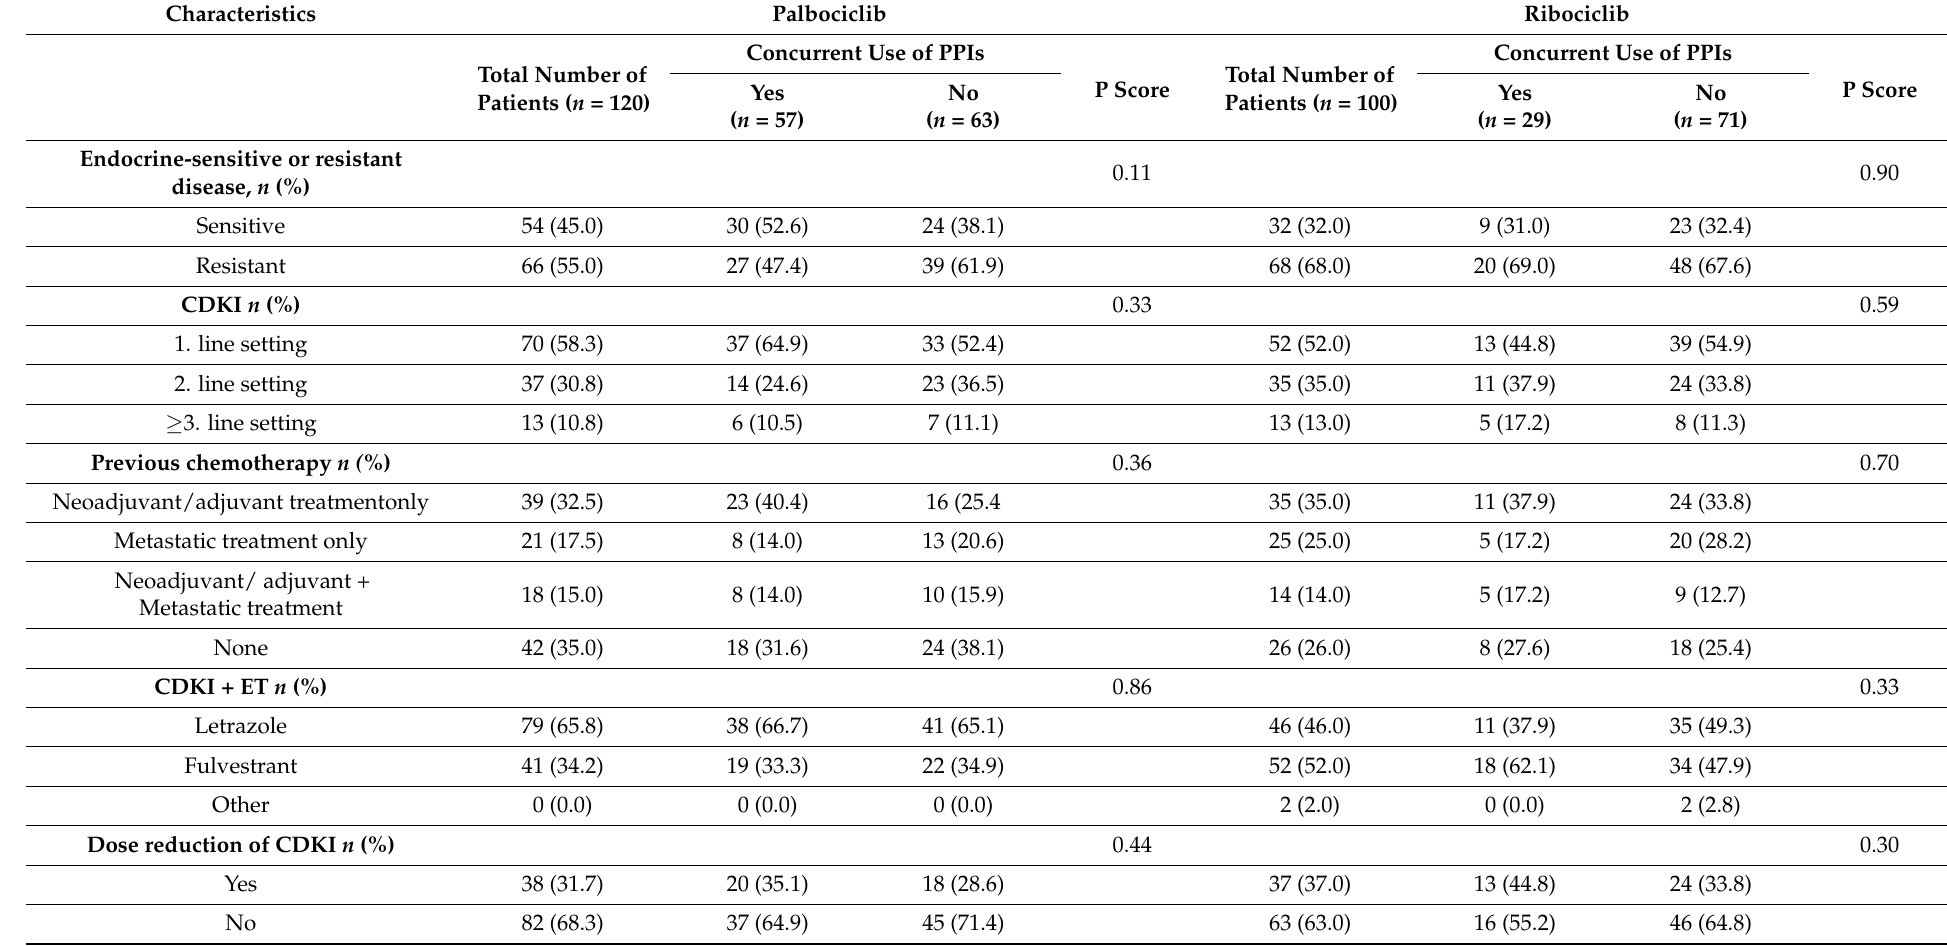
Table 2. Treatment characteristics of patients and their distribution across PPI